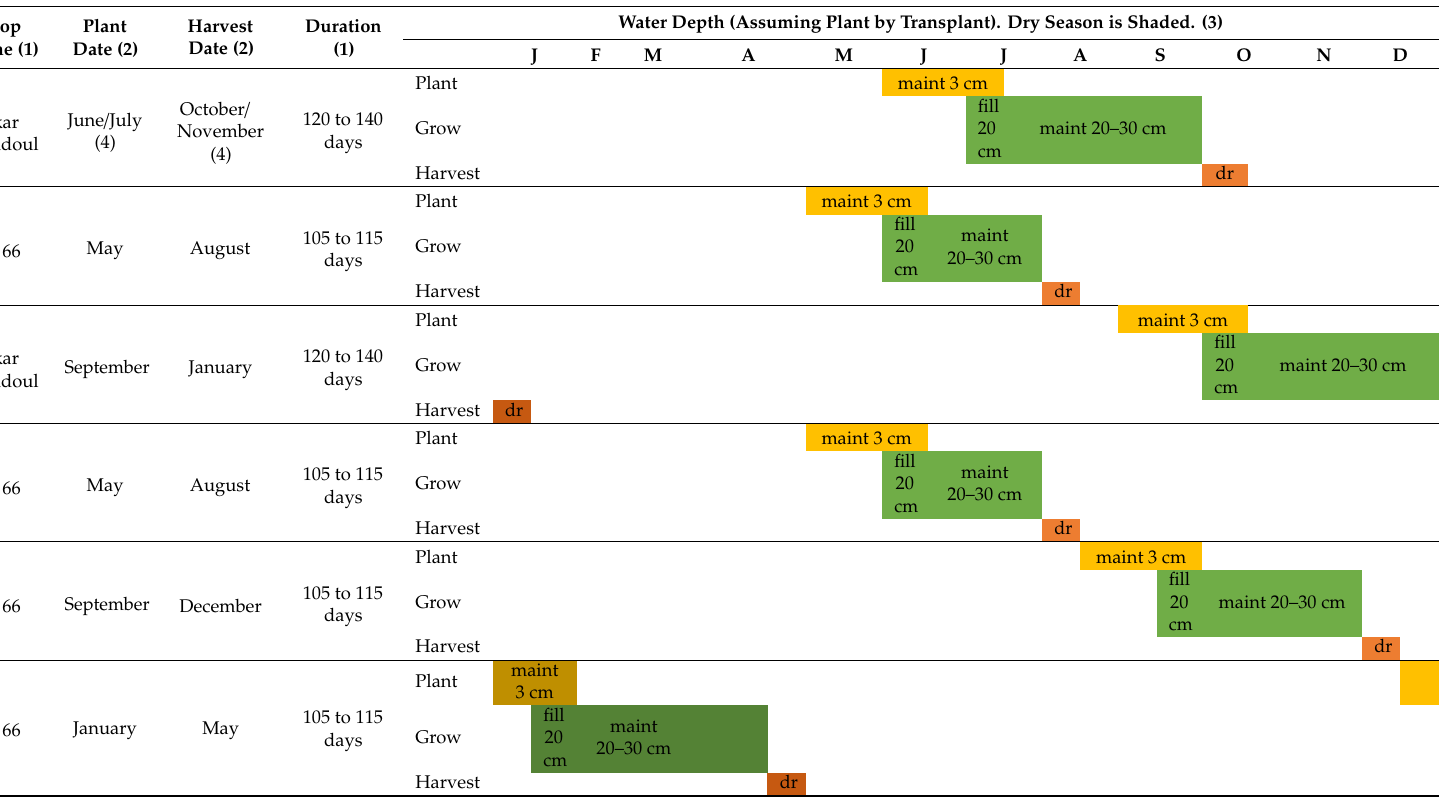
Table A3. Details of rice crop planting